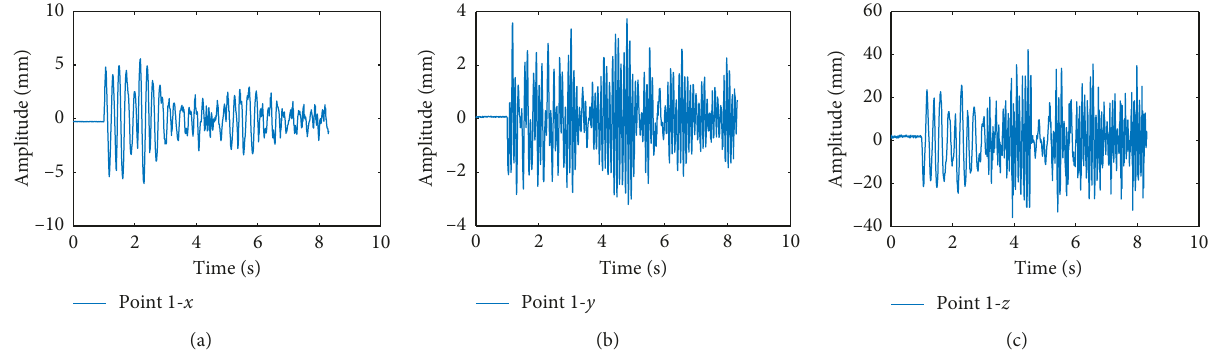
Figure 4: Vibration displacement curves of point 1 under random excitation: (a) X direction, (b) Y direction, and (c) Z direction.